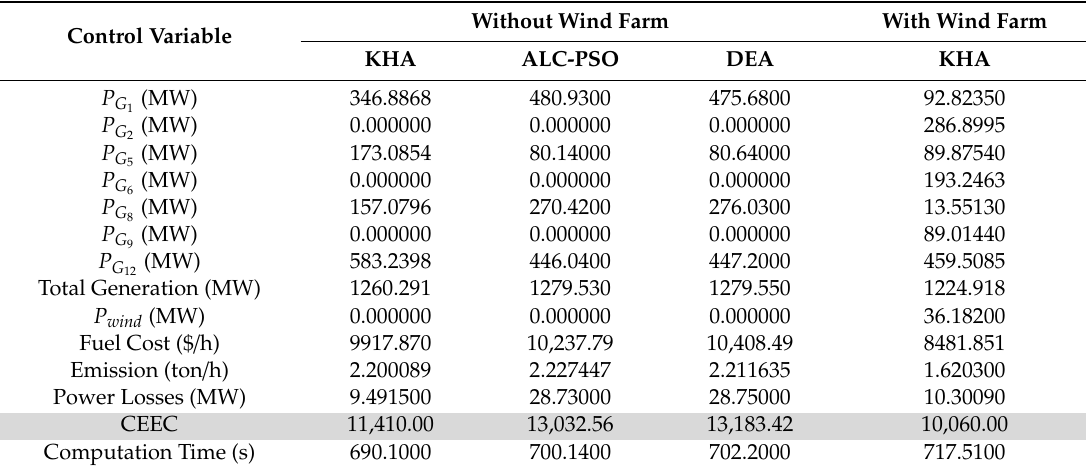
Table 11. Results for CEEC minimization for the Test System 2.